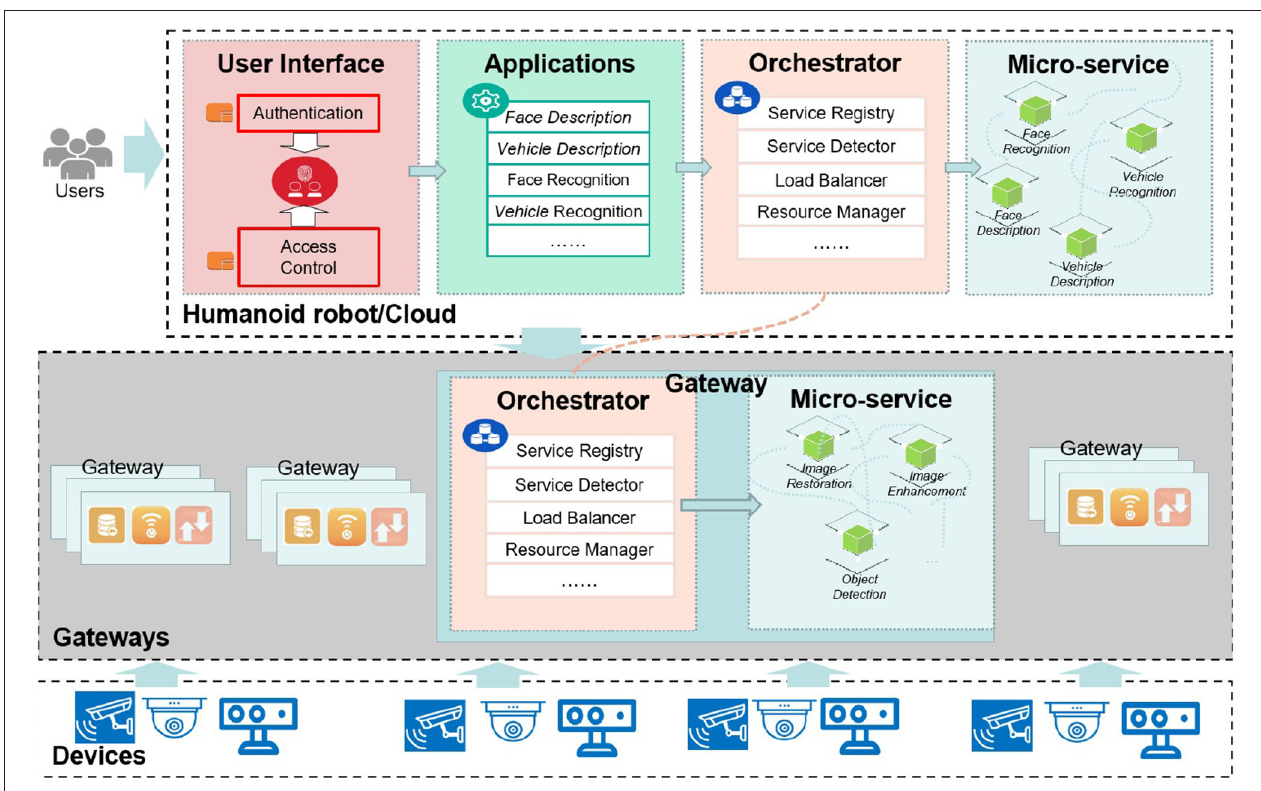
FIGURE 5 | Architecture of